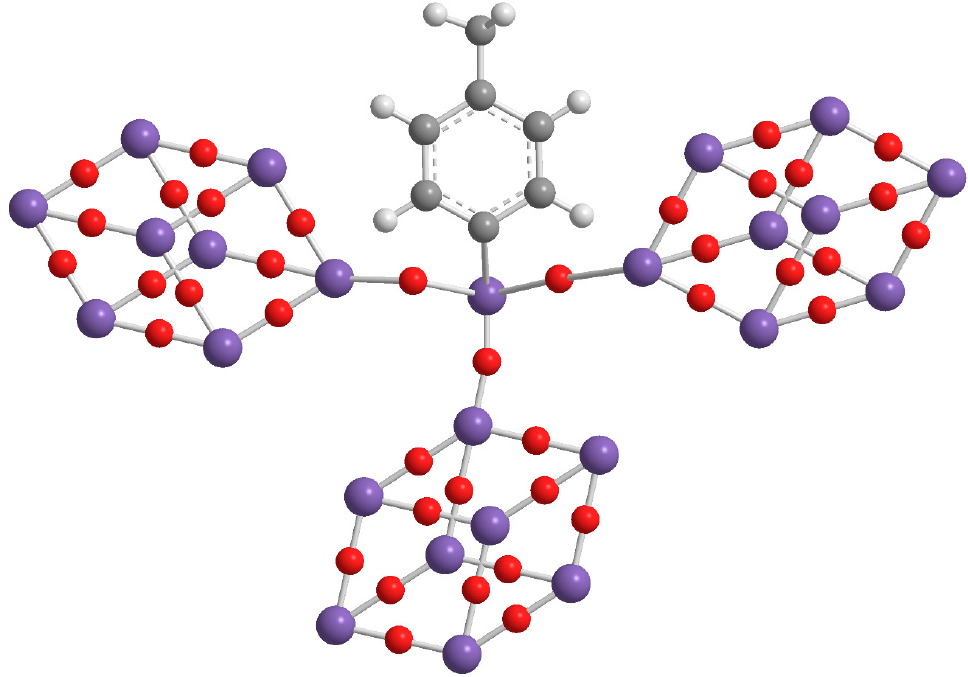
Figure 4. Molecular structure of three-cages POSS molecule.